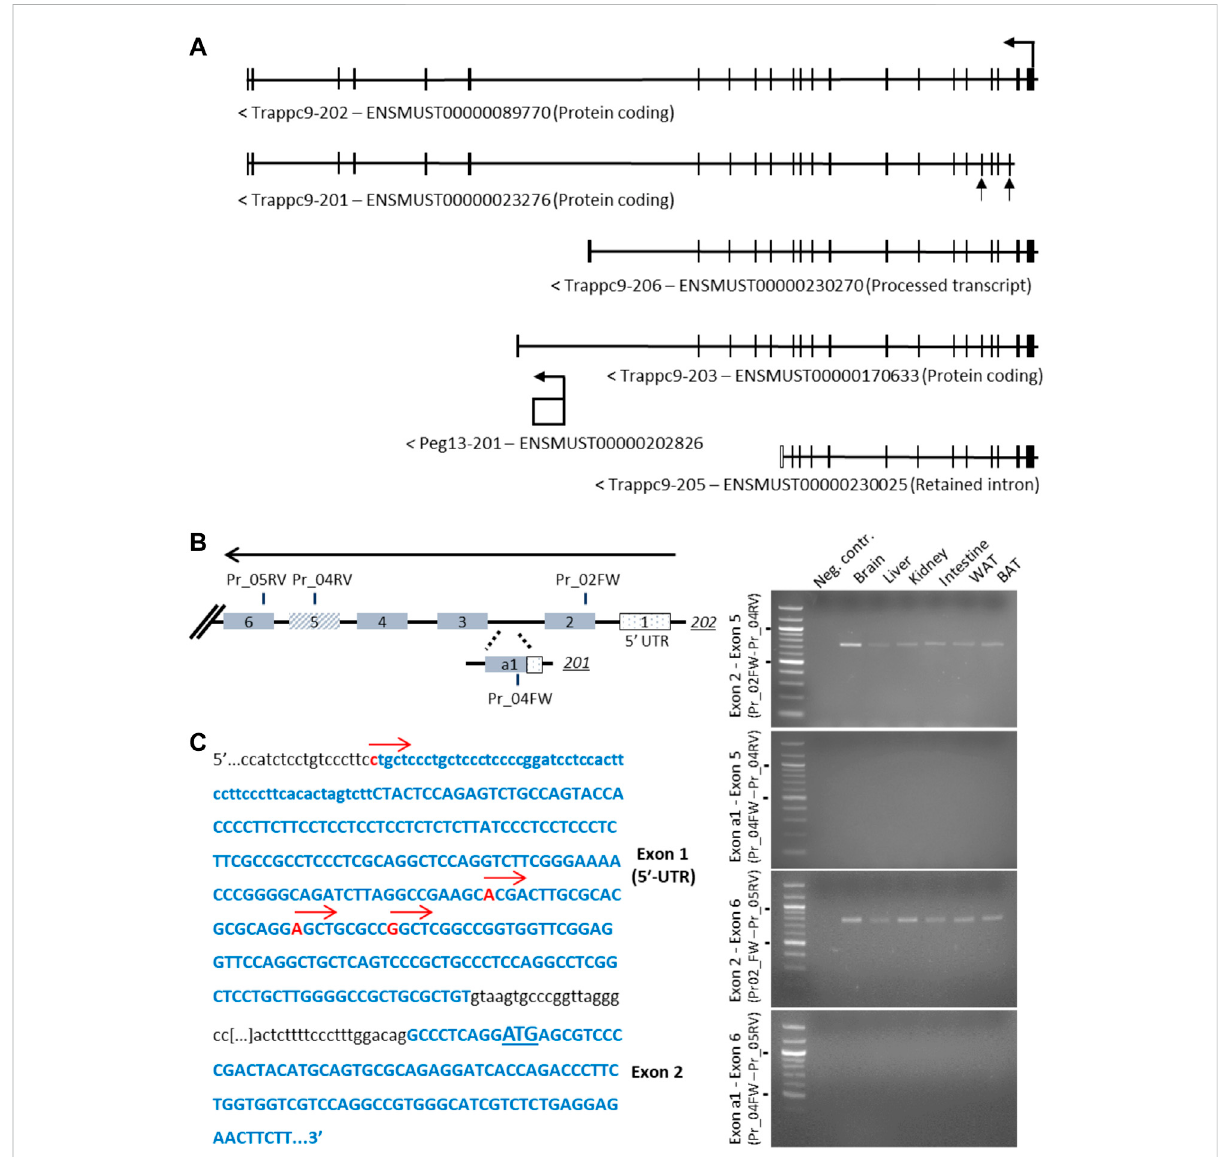
FIGURE 1 Analysis of alternative 5 ′ -exons and transcriptional start sites of Trappc9 . (A) Scheme of transcript variants 202 , 201 , 206 , 203 and 205 as indicated on ENSEMBL. The alternative exons of variant 201 , a1 and 5, are indicated by arrows. (B) Scheme of exons and primers used in RT-PCR (right)ontotalC57BL/6JRNAfrommultipletissuesusingprimercombinationsspeci fi cfortranscript 202 exon2ortranscript 201 exona1withshared downstream primers in exons 5 and 6 (indicated in the scheme with FW and RV annotations). While expression of transcript 202 exons 2 – 5and 2 – 6 (expected: 740 bp and 780 bp, respectively) was con fi rmed in multiple tissues, no expression involving transcript 201 exon a1 was detectable (expected: 318 bp and 358 bp, respectively). Size markers of 500 and 1,000 bp are indicated. (C) Sequencing of 5 ′ -RACE RCR products using